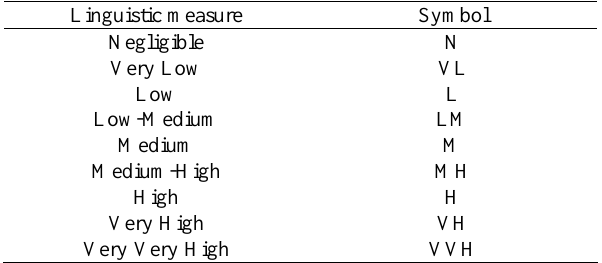
Table 5 Symbols of fuzzy variables of inputs